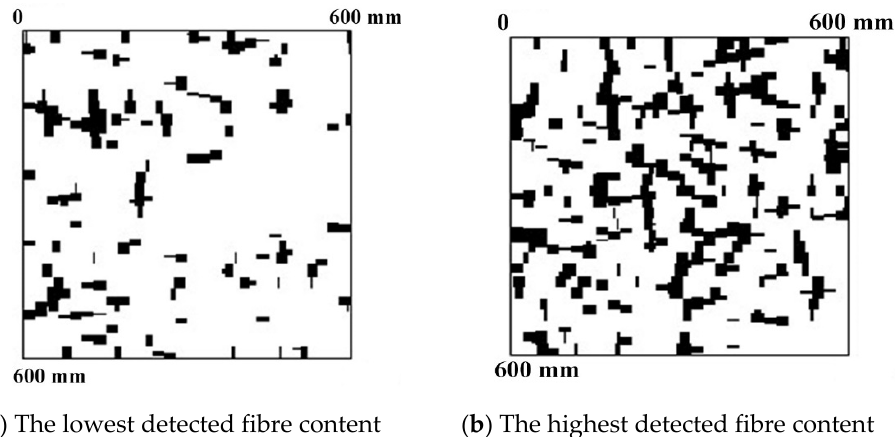
Figure 3. Images of detected fibre (using the electromagnetic induction technique) in different tested areas at the same depth of 30 mm.